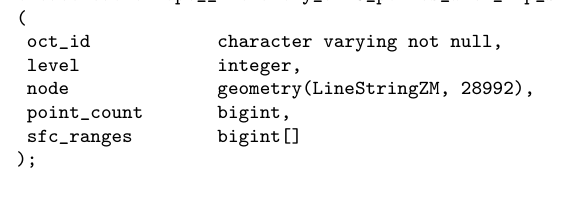
Figure 3. Blocks table, storing nodes of the octree